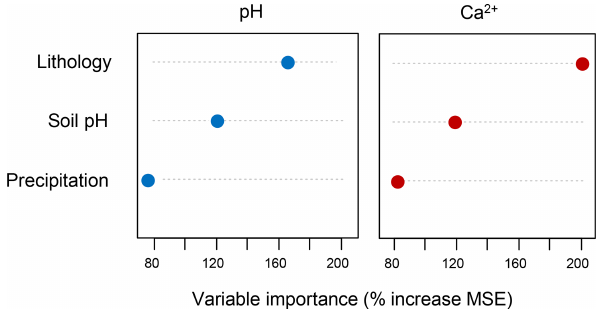
Figure 3. Variable importance of random forest models computed for groundwater pH and Ca 2 + . MSE: mean standard